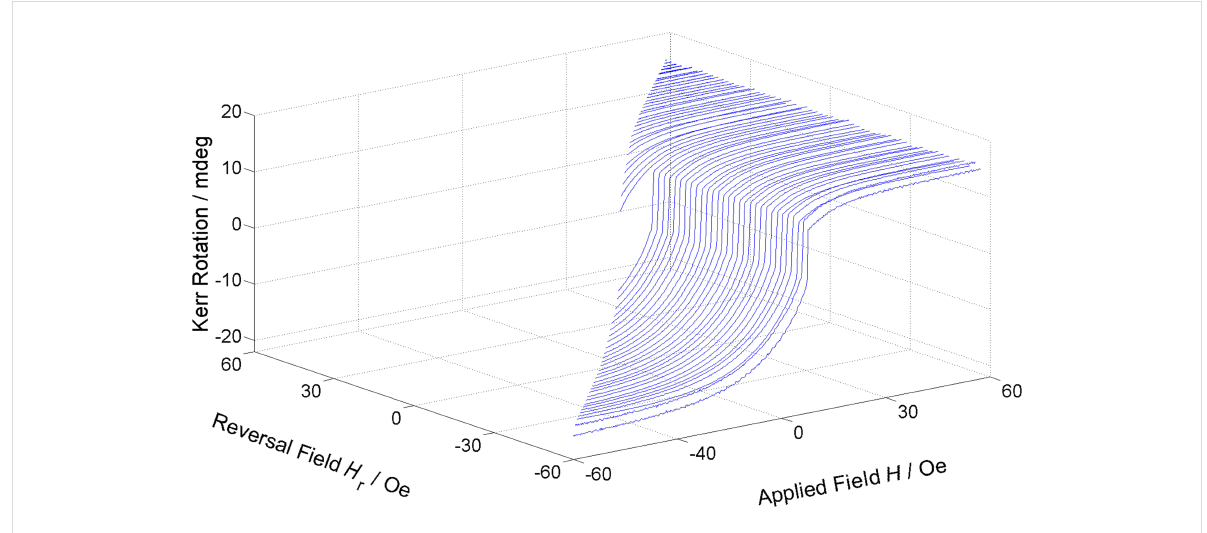
Figure 3: Exemplary set of minor loops for 61 reversal fields H r with Δ H r = 2 Oe from which the FORC density can be calculated according to Equa- tion 1. Reproduced with permission from [23], copyright 2014 AIP Publishing